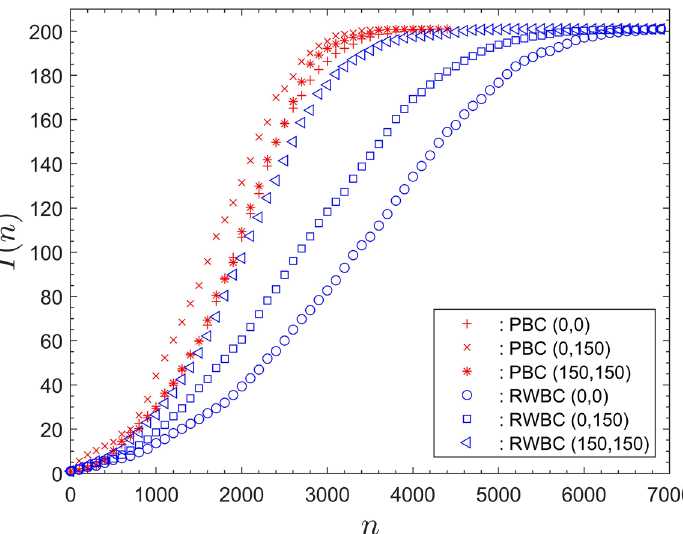
Figure 3. The number of infected, I as a function of the iteration step n , for different starting positions (0, 0) , (0, 150) and (150, 150) . Comparison of periodic boundary conditions to rigid-wall boundary